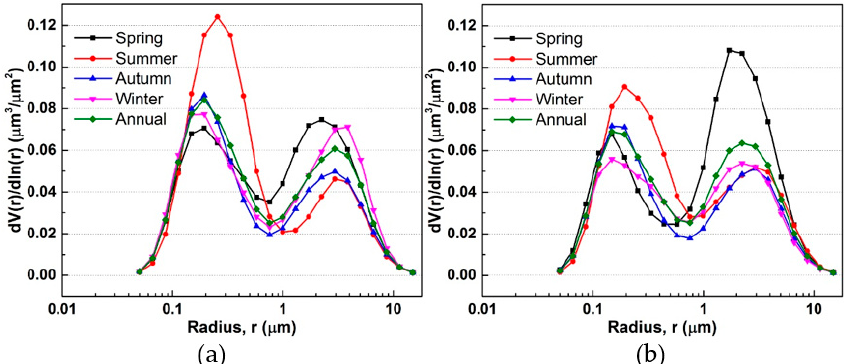
Figure 10. Annual and seasonal average aerosol volume size distribution in ( a ) Wuhan and ( b ) Dengfeng.